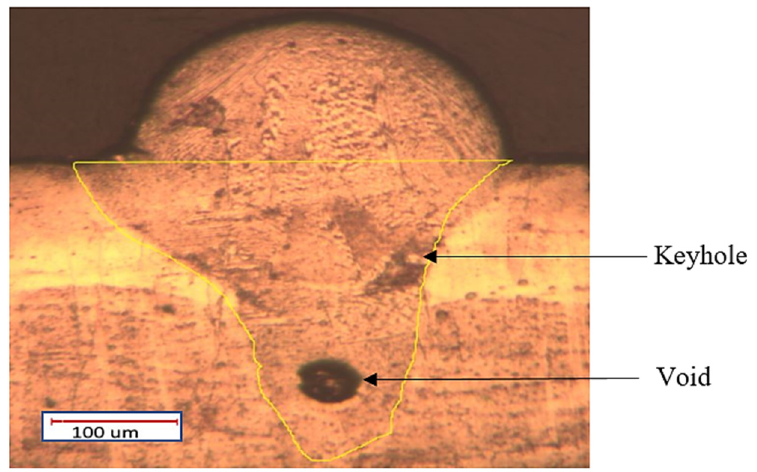
Figure 3. Voids associated with keyholes